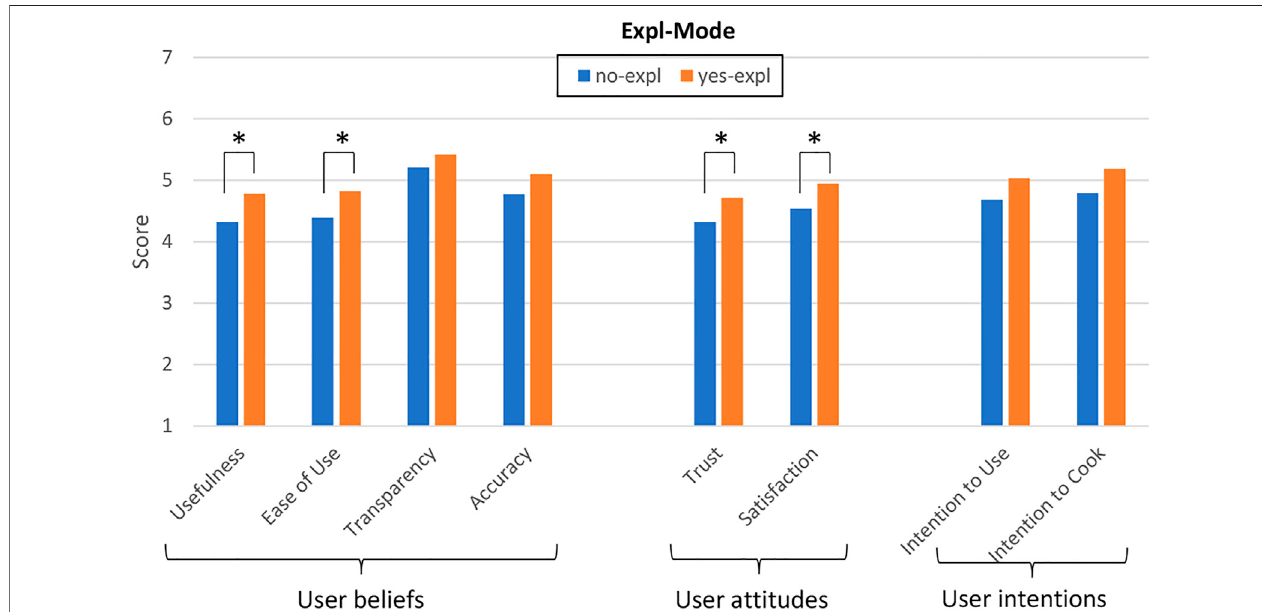
FIGURE 7 | In fl uence of the explanation mode on user beliefs and user attitudes. The differences between the means are marked according to their level of signi fi cance (* for p < 0.05, and ** for p < 0.01).